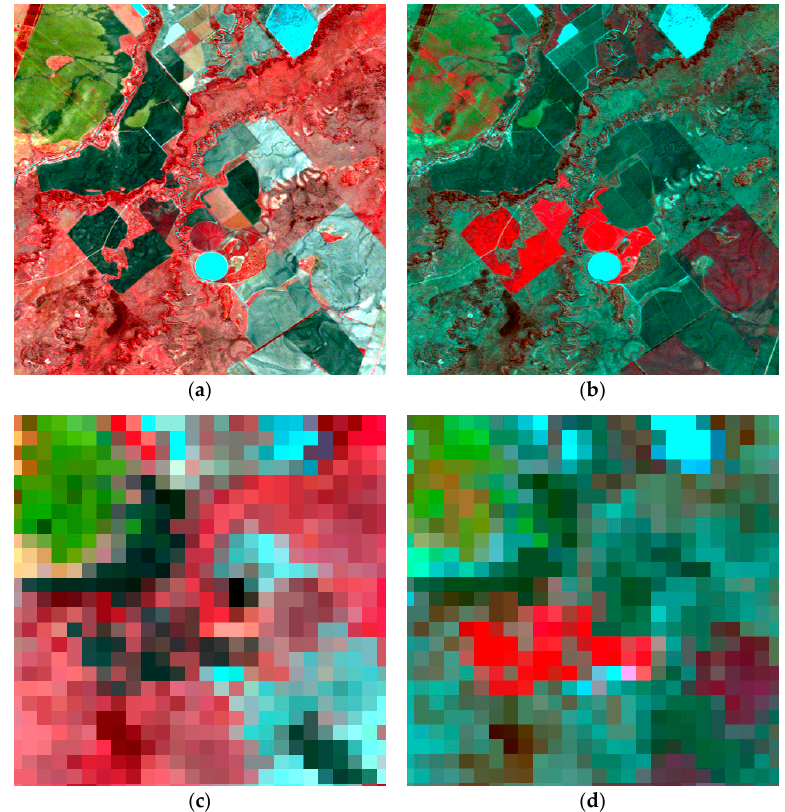
Figure 2. The first dataset exhibiting phenological changes: NIR-red-green composites of the Landsat images with a 30-m spatial resolution from ( a ) 2 May 2004 and ( b ) 5 July 2004; the corresponding MODIS images with a 500-m spatial resolution from ( c ) 2 May 2004 and ( d ) 5 July 2004.